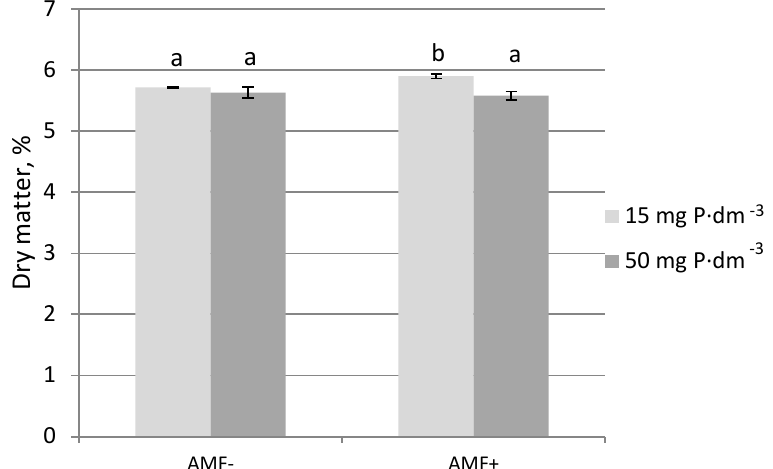
Fig. 3. Interaction between phosphorus level in nutrient solution and mycorrhiza on dry matter content in tomato fruits Means followed by different letters differ at p < 0.05.; bars indicate standard error AMF-/AMF+ – non-inoculated plants by arbuscular mycorrhizal fungi (AMF)/inoculated plants by AMF